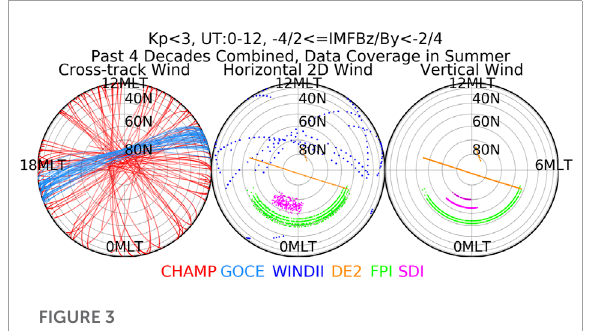
FIGURE 3 A survey of past 4 decades of neutral wind data in the Northern Hemisphere as a function of magnetic latitude and local time (quasi-dipole). Shown are the wind observation locations between 240 and 500 km during summer (May, June, July, and August combined). The geospace conditions are stated on the top and color-coded data sources at the bottom. The most significant coverage is from CHAMP and GOCE which measured only one horizontal wind component